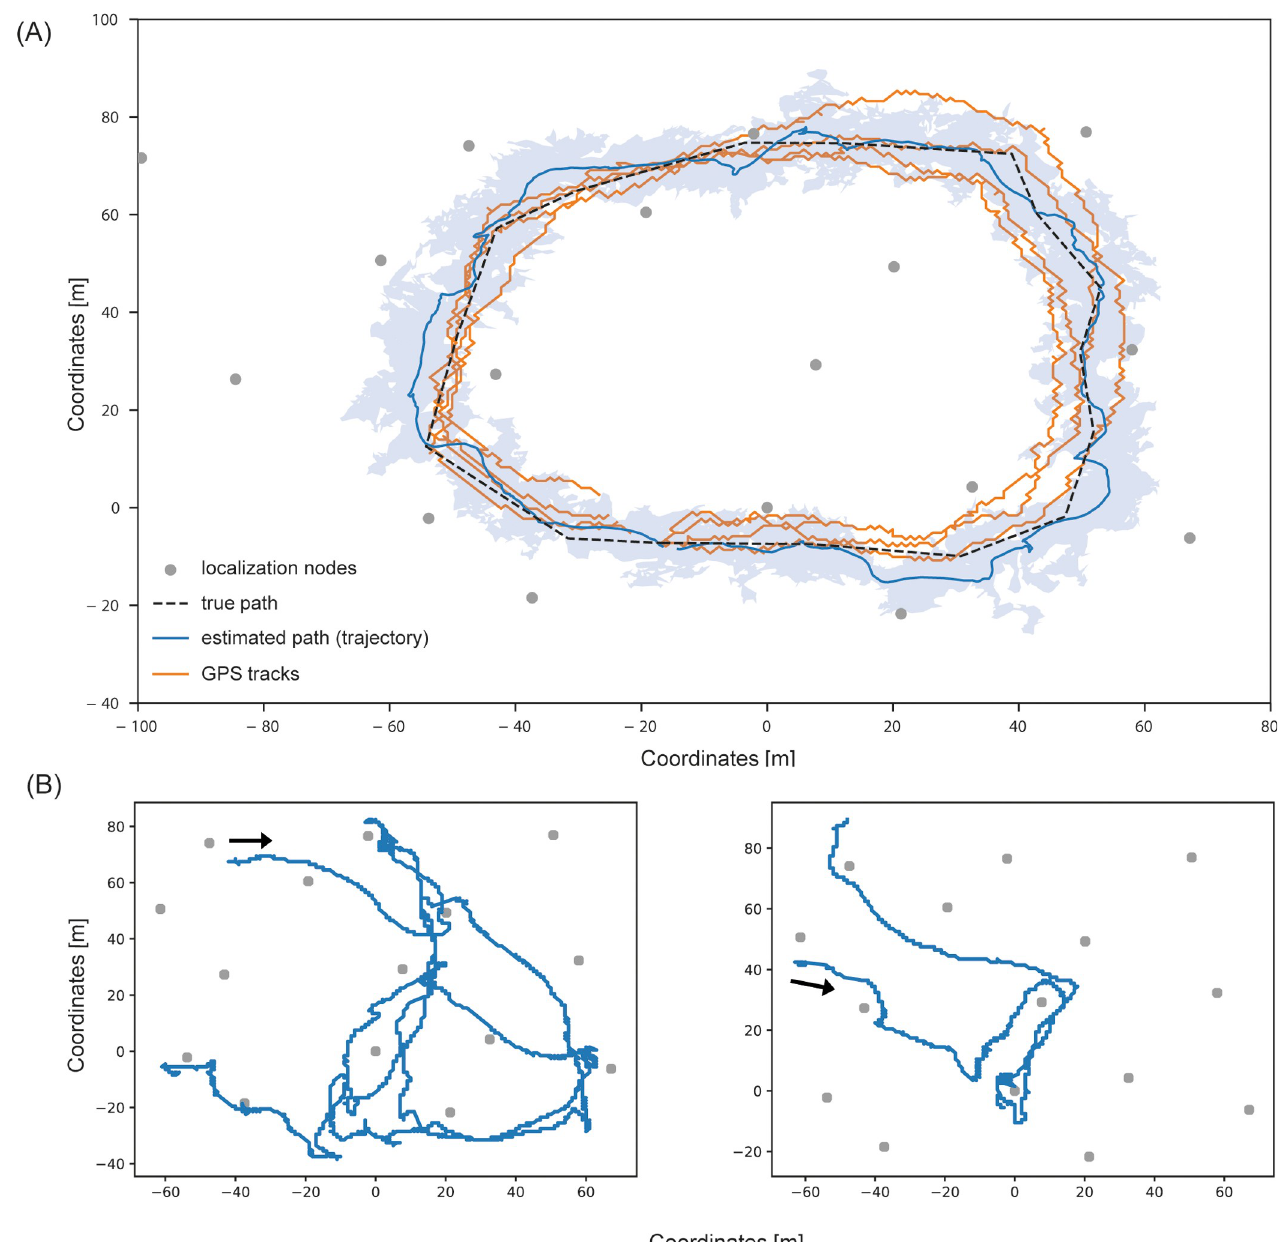
Fig 3. Tracking bat movements in a forest. (A) Tracking grid in a deciduous forest of Forchheim, Germany, consisting of 17 localization nodes (gray dots) covering an area of approximately 1.5 ha. Dashed black line: known reference path; blue line and blue shading: estimated path and average localization error obtained by the presented wireless biologging system; yellow lines: 4 individual GPS tracks. (B, C) Estimated flight trajectories of a tagged mouse-eared bat during foraging on August 2nd and 5th. Data and code used to create this figure have been archived by GFBio (https://doi.org/10.7479/vd6t-7a92). GPS, global positioning